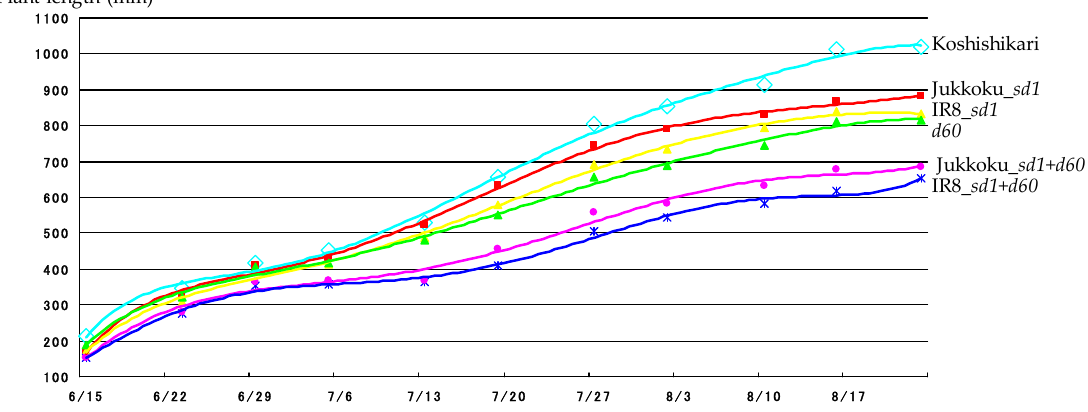
Figure 1. Effect of growth of semidwarf and double dwarf gene lines. Ten plants were randomly selected, and the distance between the ground and the highest standing point (i.e., the full length) was measured every week for approximately three months until the panicle emerged. The full length of d60 -carrying line was longer than that of sd1 -carrying lines at the time of transplanting. However, the full length of line carrying Jukkoku _sd1 and that of line carrying IR8 _sd1 exceeded that of line carrying d60 on June 23 (43 days after sowing) and on July 13 (64 days after sowing), respectively: full length in lines carrying either Jukkoku _sd1 or IR8 _sd1 was longer than that in line carrying d60 at the time of final measurement (August 23, 103 days after sowing). Table 1. Plant length of semidwarf and double dwarf gene lines.